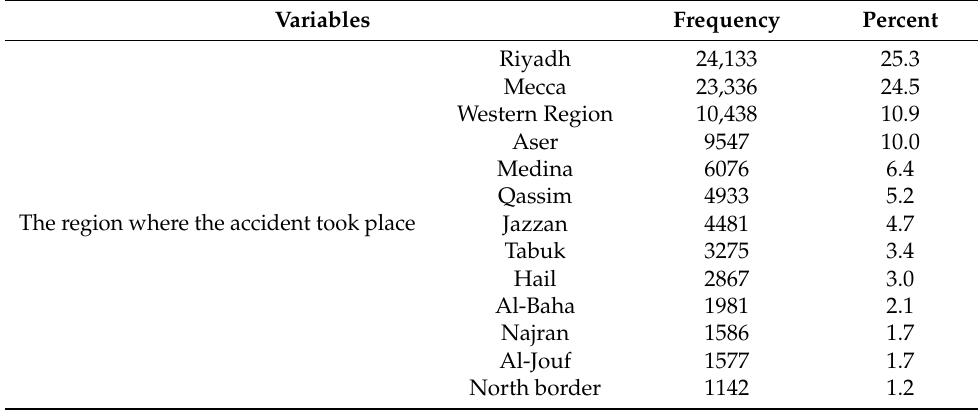
Table 1. Place of accidents and characteristics of the road traffic accident victims in the